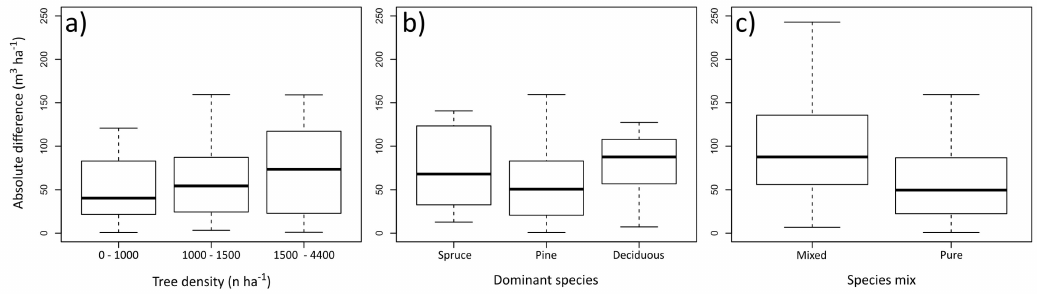
Figure 8. Boxplots of the absolute di ff erence (m 3 ha − 1 ) between the plot-level field measured and the UAV-LS estimated V categorized according to ( a ) tree density, ( b ) dominant species, and ( c ) species